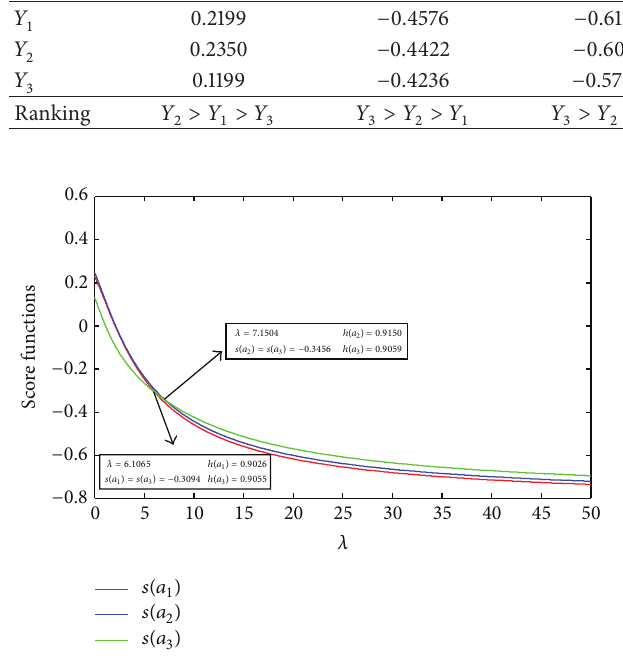
Figure 2: Variation of the score functions with respect to the parameter 𝜆